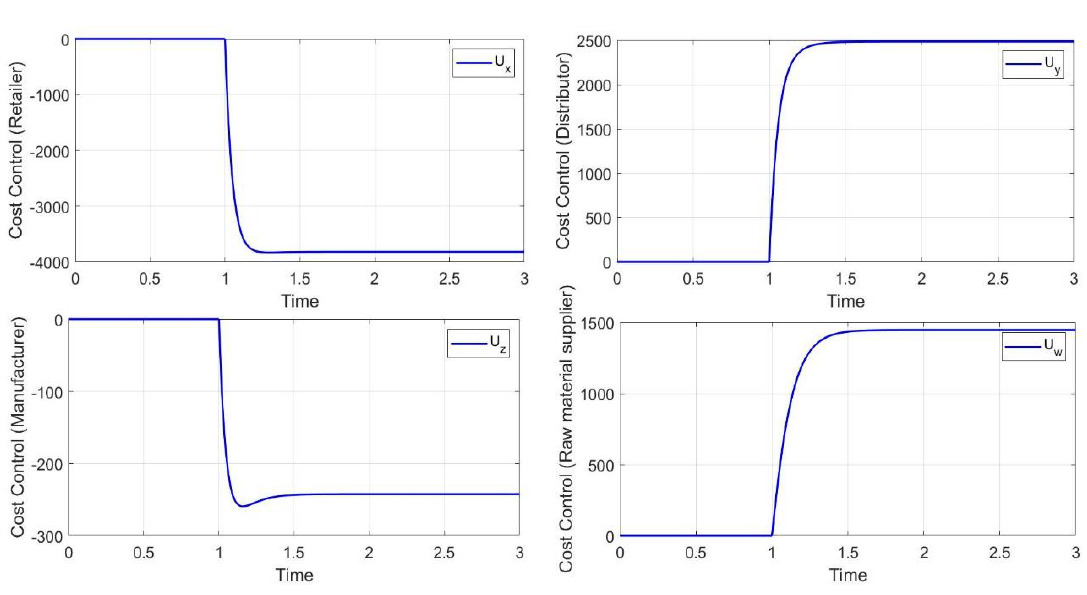
Fig. 10. Cost control for elimination of hyperchaos supply